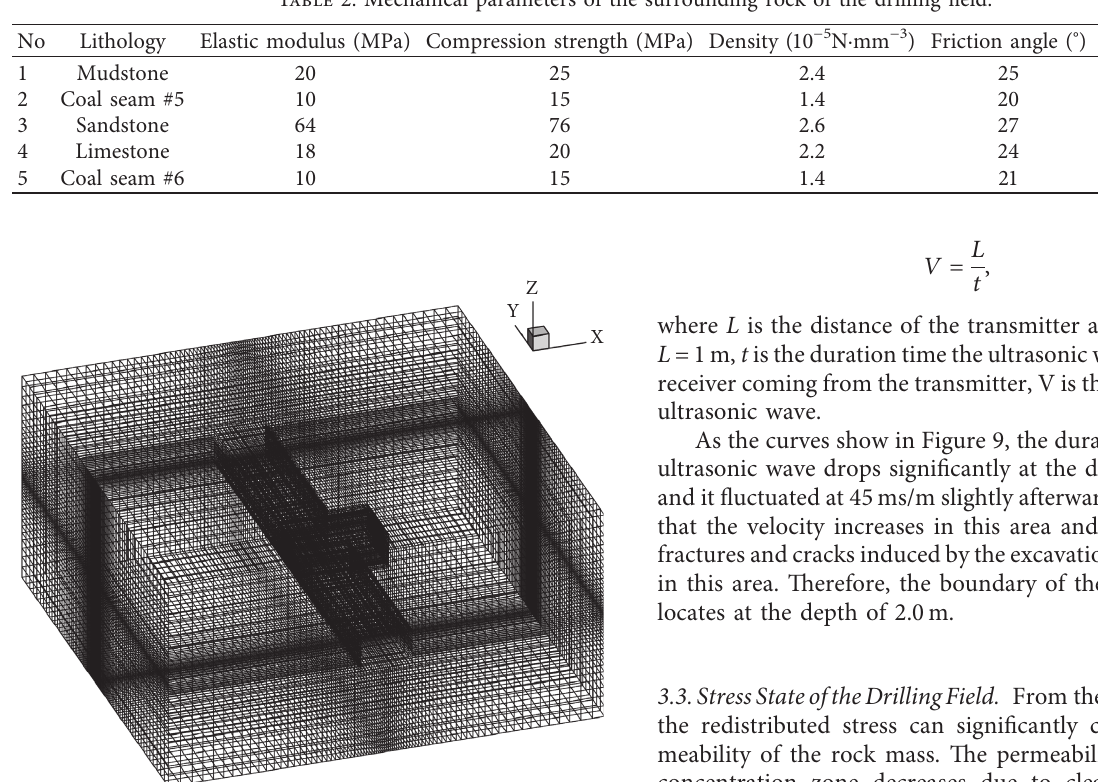
Figure 5: 3D mesh of the numerical